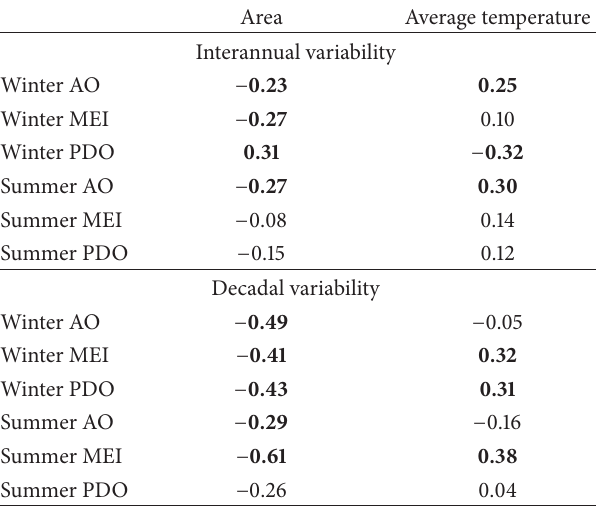
Table 1: Correlation coefficients between the AO, MEI, PDO, and the YSCWM area and temperature in August, including the interannual and decadal components in both summer and winter. Values in bold are statistically significant at the 95% confidence